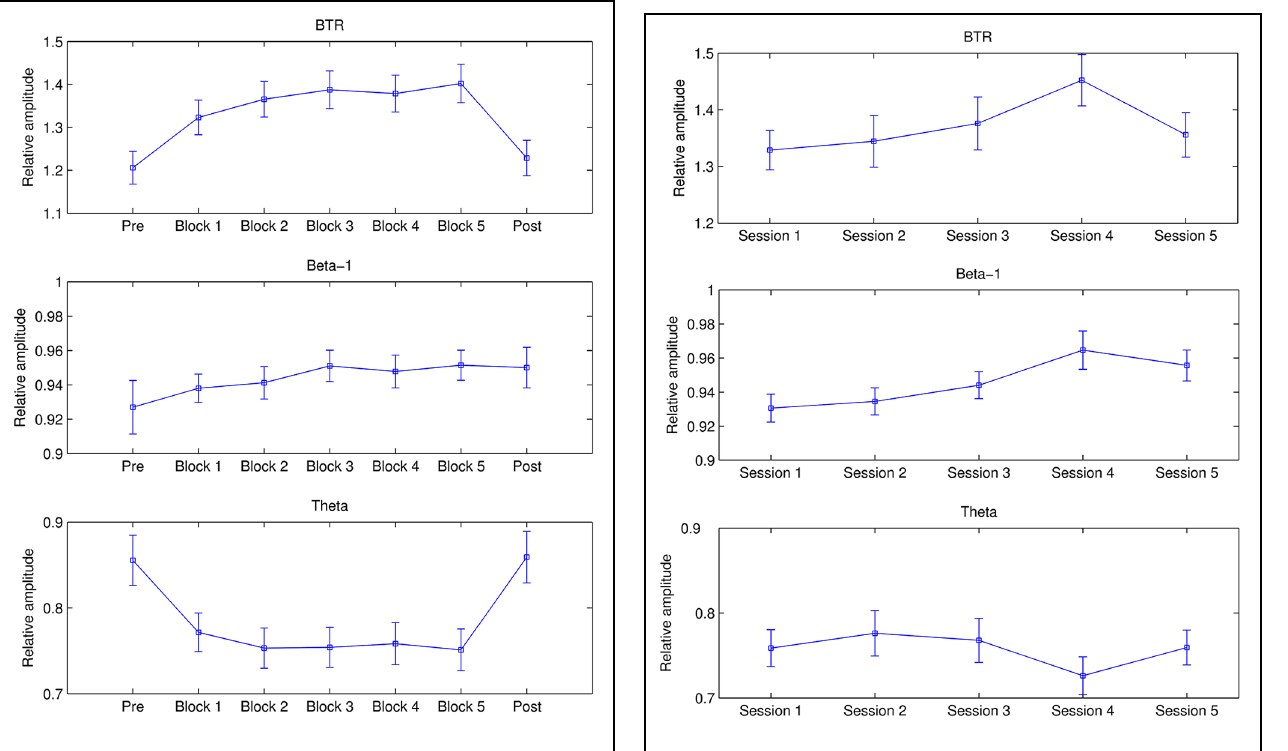
Frontiers in Human Neuroscience |